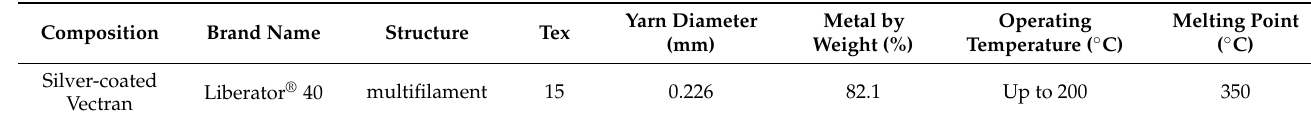
Table 1. Overview of Vectran (Liberator ® 40) conductive yarn.